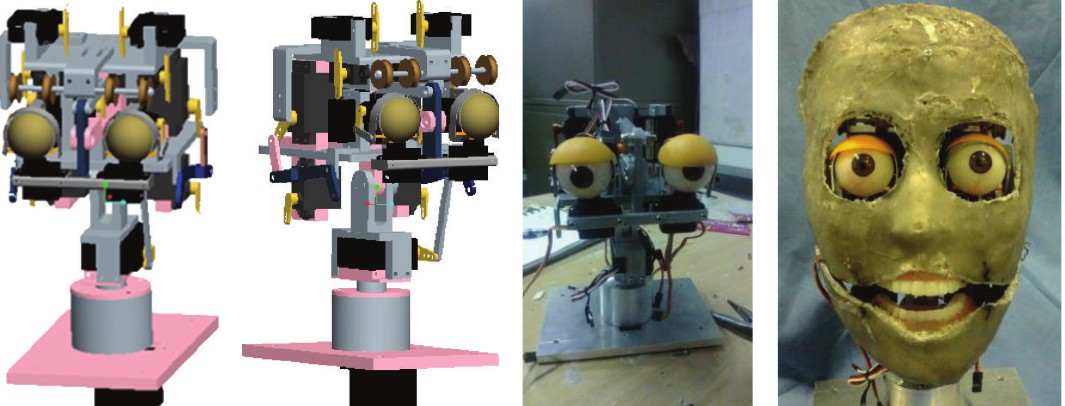
Figure 4: Mechanical structure of robot head.